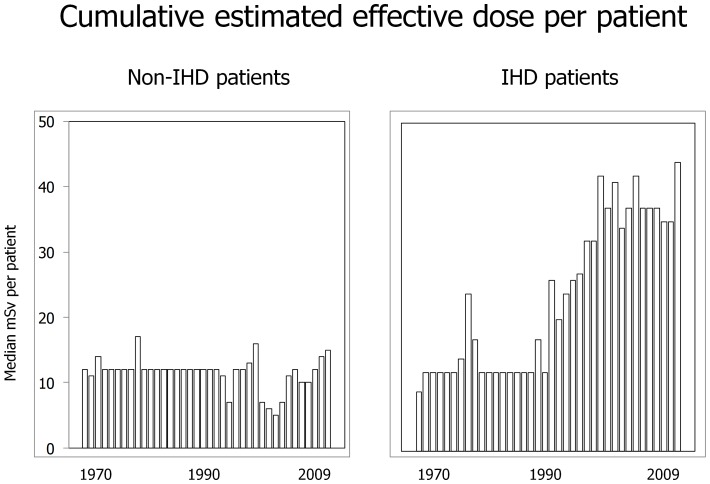
Secular trends of cardiovascular medical radiation exposure over the last 40 years in in-hospital patients admitted for cardiovascular disease.Radiation exposure is expressed as cumulative estimated effective dose/patient. On the left panel the trend of non-ischemic (non-IHD) patients, and on the right the one of ischemic (IHD) patients.